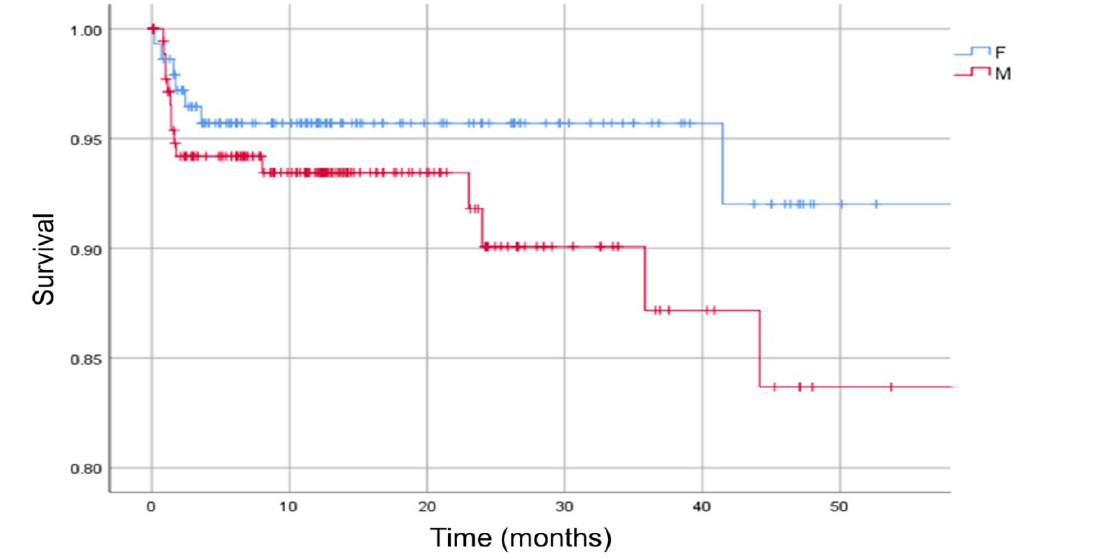
Figure 3. Kaplan-Meier survival curve. The analysis is separated in females (F) and males (M). Vertical marks indicate censoring.